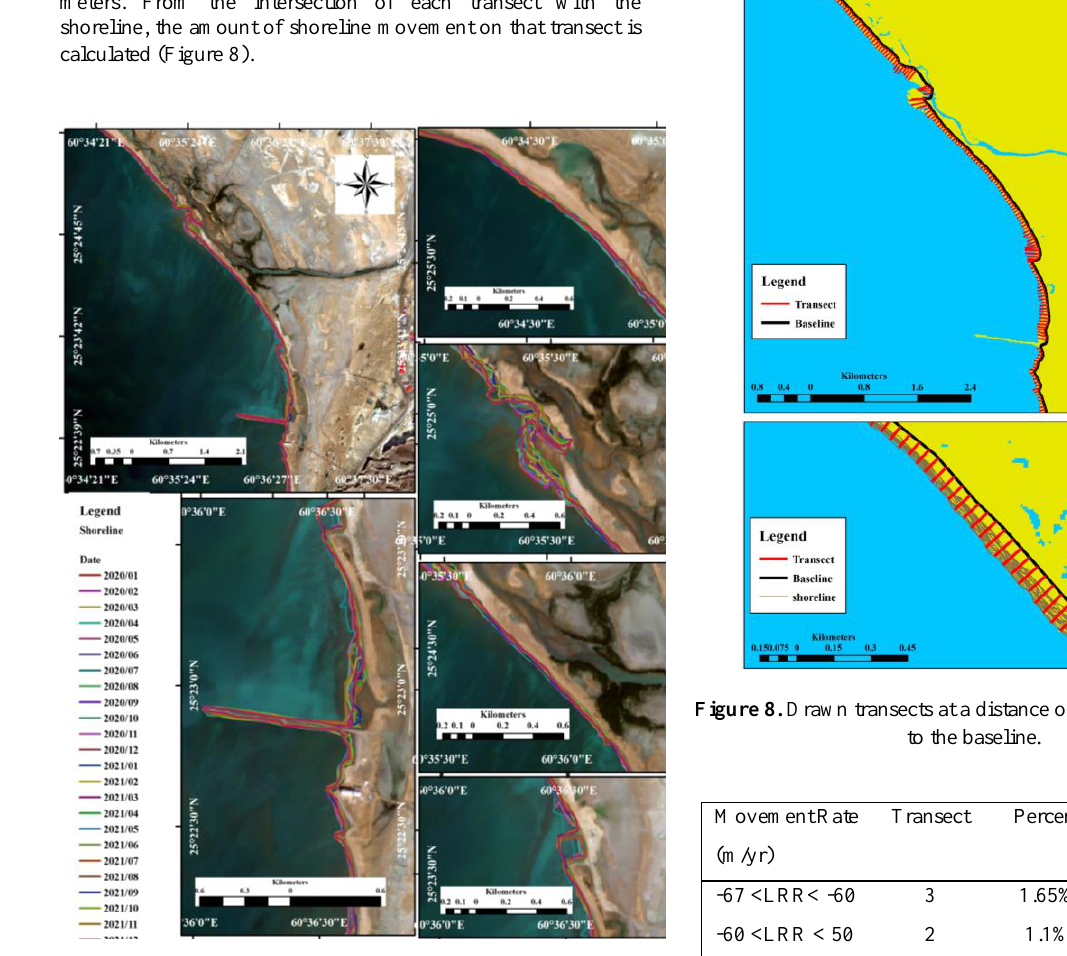
Figure 7. Shoreline of Chabahar from 2020/01 to 2021/12.